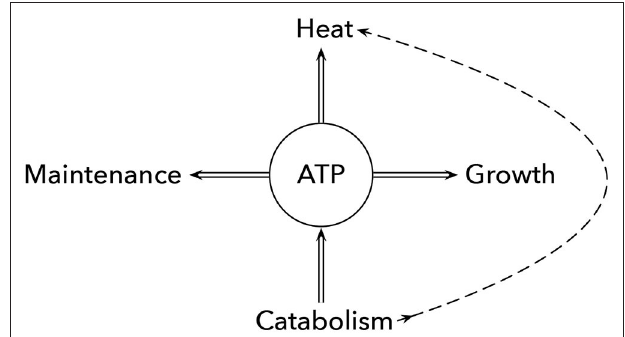
FIGURE 1 | Intrinsic vs. excess metabolic heat production. Catabolism of food yields ATP and intrinsically generated metabolic heat (dashed curve). A cell may use the free energy added to the ATP/ADP disequilibrium to drive cellular maintenance and growth. Alternatively, the ATP/ADP disequilibrium can drive futile biochemical processes that may function to relieve biochemical imbalances or to generate excess beneficial heat. Any benefit of excess heat trades off against lost ATP/ADP disequilibrium to drive maintenance and growth. Alternatively, cells can generate excess metabolic heat by reducing the ATP produced during catabolism and increasing the direct heat generated along the dashed curve. For example, allowing proton motive force to cross the membrane without driving ATP synthase increases the heat production associated with the ion flow, as can happen in the electron transport chain or similar processes. Approximate calculations intended only to provide a rough sense of magnitude suggest that a cell aerobically respiring its own weight in glucose produces enough intrinsic metabolic heat to raise cellular temperature by about 2 ◦ C and enough ATP that could be used to generate additional excess metabolic heat to raise temperature by another 2 ◦ C. Cells that bypass ATP production and act almost purely as excess heat producers may be able to increase maximum metabolic rate because they have a larger free energy gradient between glucose and the final metabolic products. Modified from Figure 1 of Russell